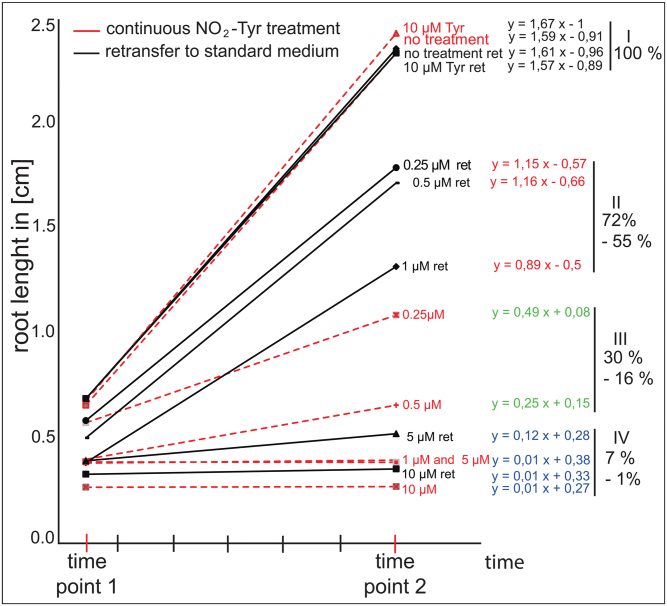
Growth effects induced by 3-nitro-l-tyrosine (NO2-Tyr) concentrations are reversible. Seedlings were grown on standard medium for 4 d and were subsequently transferred to growth medium containing different NO2-Tyr concentrations as indicated for 1.5 d (time point 1). Then, half of the seedlings were retransferred to standard medium for an additional 4.5 d (time point 2). Root length before (time point 1) and 4.5 d after retransfer (time point 2) is plotted over time. Black curves (continuous line) indicate samples retransferred onto standard medium plates, and red curves (dashed lines) indicate samples that were transferred to freshly prepared NO2-Tyr medium (continuous NO2-Tyr treatment). Equations of linear regression curves are indicative of growth rate performance and are given for each treatment. The equations are grouped into four classes (I –IV) based on the similarity of their slope. Class I contains non-transferred and retransferred control samples and represent 100% of the growth rate potential. Class II comprises samples retransferred from low NO2-Tyr concentrations (0.25, 0.5, and 1 μm ret). Class III contains samples continuously treated with low NO2-Tyr concentrations (0.25 μM and 0.5 μM). Class IV includes high NO2-Tyr concentrations (1, 5, and 10 μM, 5 μM ret and 10 μM ret). Percentage ranges indicate growth performance as achieved in each class as a means to illustrate growth recovery relative to the potential growth as measured for controls (100%).